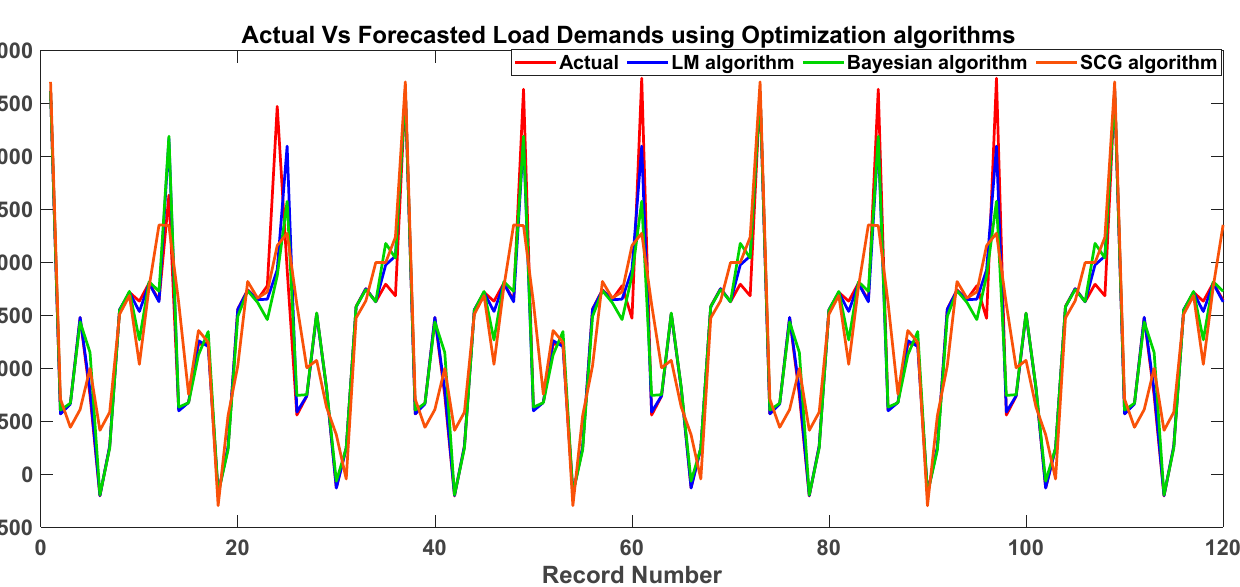
Figure 16. Forecasted load demand plots of ANN with Levenberg–Marquardt (LM) algorithm, Bayesian Regulation (BR) algorithm, and Scaled Conjugate Gradient (SCG) algorithm. Table 3. Quantitative regression analysis of various optimization algorithms of ANN.